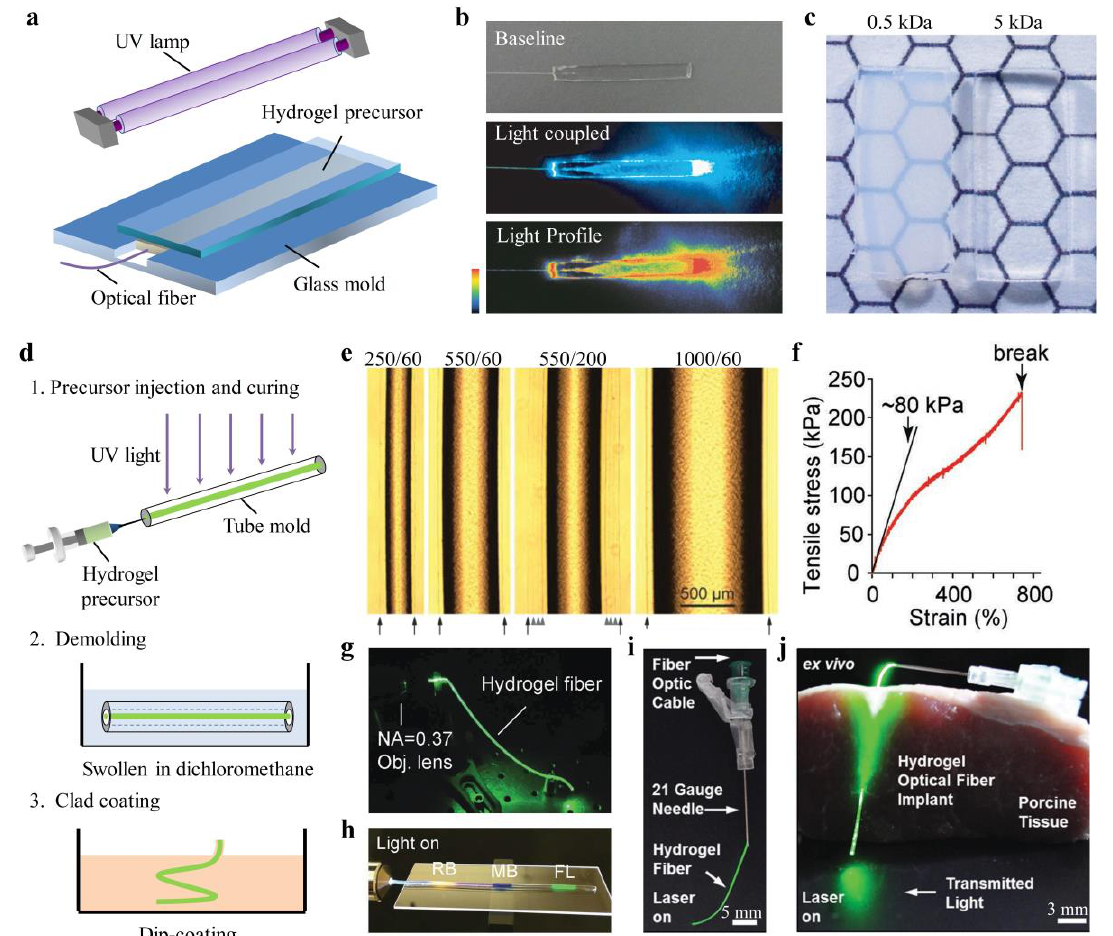
Figure 1. Hydrogel optical waveguides. ( a ) Fabrication method of a slab polyethylene glycol diacrylate (PEGDA) hydrogel waveguide [36]; ( b ) Light coupling to the slab hydrogel waveguide. Reproduced with permission [39]. Copyright 2013, Nature Publishing Group; ( c ) Photographs of the two hydrogel samples with molecular weight of 0.5 kDa and 5 kDA. Reproduced with permission [36]. Copyright 2013, Nature Publishing Group; ( d ) Fabrication steps of a step-index, core-cladding hydrogel optical fiber [32]; ( e ) Phase-contrast images of the core-cladding hydrogel fibers of di ff erent sizes. Reproduced with permission [32]. Copyright 2015, Wiley; ( f ) Stress-strain curve of a stretchable and tough hydrogel optical fiber. Reproduced with permission [39]. Copyright 2016, Wiley; ( g ) Light-guiding in a tough hydrogel optical fiber. Reproduced with permission [39]. Copyright 2016, Wiley; ( h ) Hydrogel optical fiber doped with multiple dye molecules for multiplexed strain sensing. RB, rhodamine B; MB, methylene blue; FL, fluorescein. Reproduced with permission [39]. Copyright 2016, Wiley; ( i ) Hydrogel optical fibers integrated with needles to create insertable devices. Reproduced with permission [40] Copyright 2017, Wiley; ( j ) Hydrogel optical fibers implanted in porcine tissue. Reproduced with permission [40]. Copyright 2017,